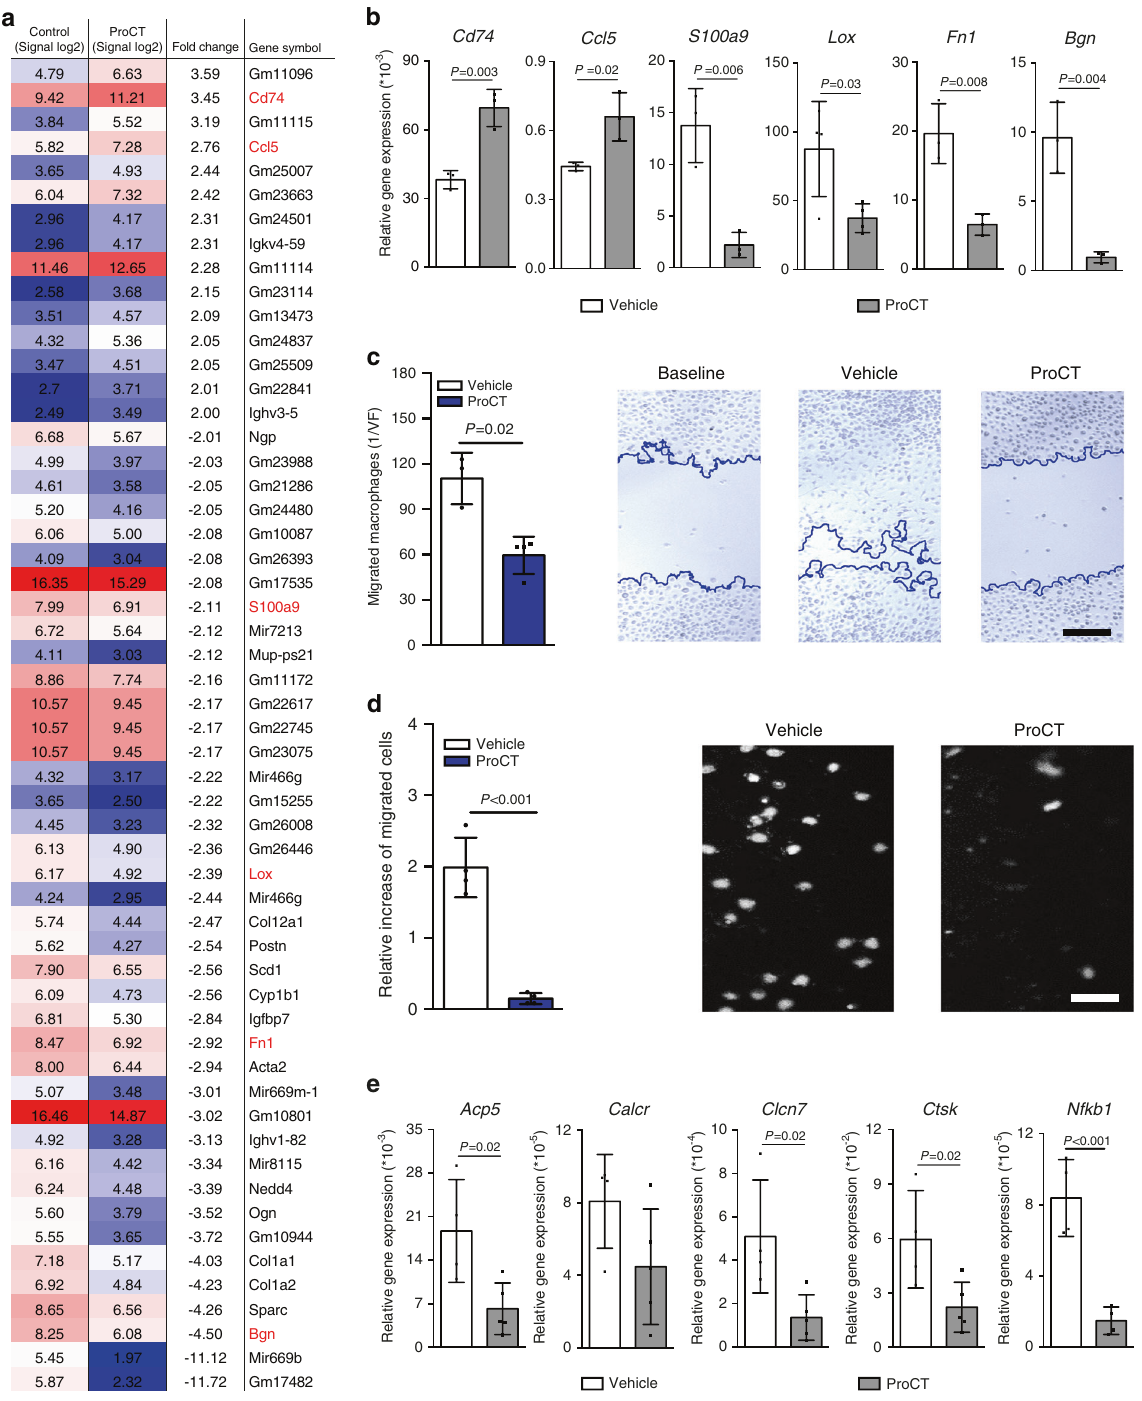
Fig. 7 ProCT arrests macrophage migration in vitro. a Log signal intensity ratios and relative (fold) expression levels of genes with differential expression in macrophages on Day 7 of differentiation, after treatment with vehicle or ProCT (200 ng·mL − 1 ) for 6 h, as determined by genome- wide expression analysis. Pooled mRNA from n = 4 independent experiments (Tukey ’ s biweight average algorithm). The colors in the heatmap indicate absolute signal intensity values (high = red; intermediate = white; moderate = blue). b qRT – PCR analysis (virtual copy number per Gapdh copy number) of the indicated genes in independent macrophage cultures on Day 7 of differentiation, after stimulation with ProCT (200 ng·mL − 1 ) for 6 h. n = 3 – 4 independent experiments. c Quanti fi cation of migration in primary macrophages treated with vehicle or ProCT for 24 h (scratch assay). Representative images of the cultures are shown on the right, where the blue lines indicate the migration fronts of stimulated cells (scale bar = 100 μ m). n = 3-4 independent cultures per group. d Quanti fi cation of macrophage migration across a Transwell membrane toward the chemokine CCL2 during incubation with vehicle or ProCT for 6 h. Representative DAPI staining of the migrated cells is shown on the right (scale bar = 50 μ m). n = 4 independent experiments per group. e qRT – PCR analysis (virtual copy number per Gapdh copy number) of the indicated genes in macrophage cultures undergoing osteoclast fusion after stimulation with RANKL (40 ng·mL − 1 ) in the presence or absence of ProCT for 6 h (200 ng·mL − 1 ). n = 4 − 5 independent cultures per group. For ( b – e ), unpaired Student ’ s t test was